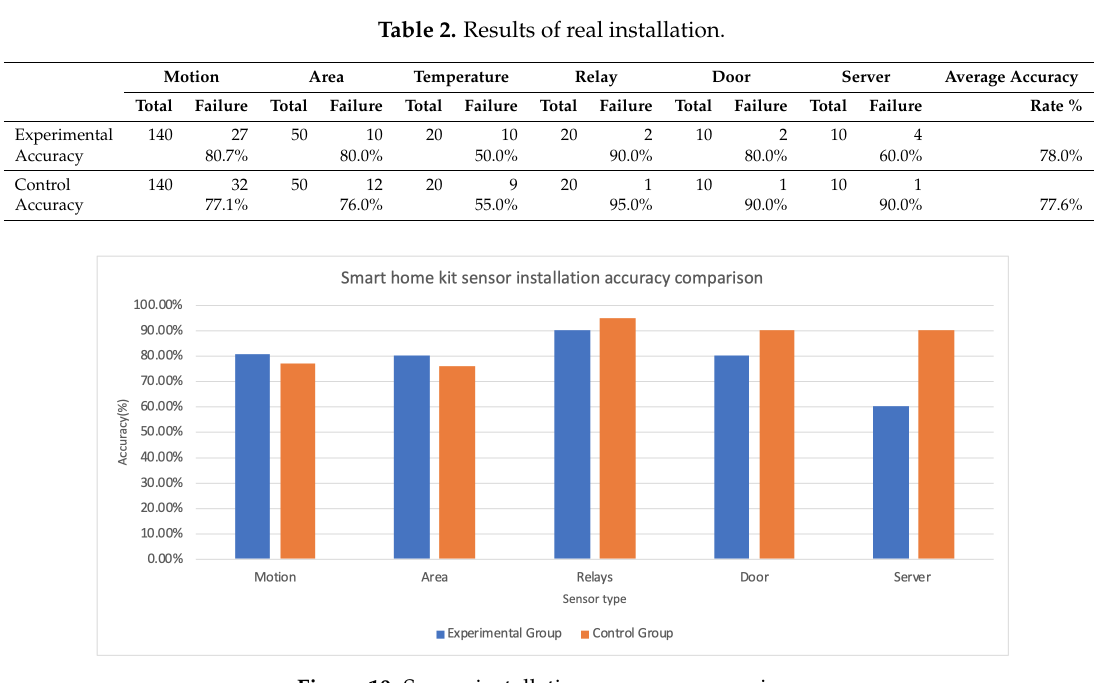
Figure 10. Sensor installation accuracy